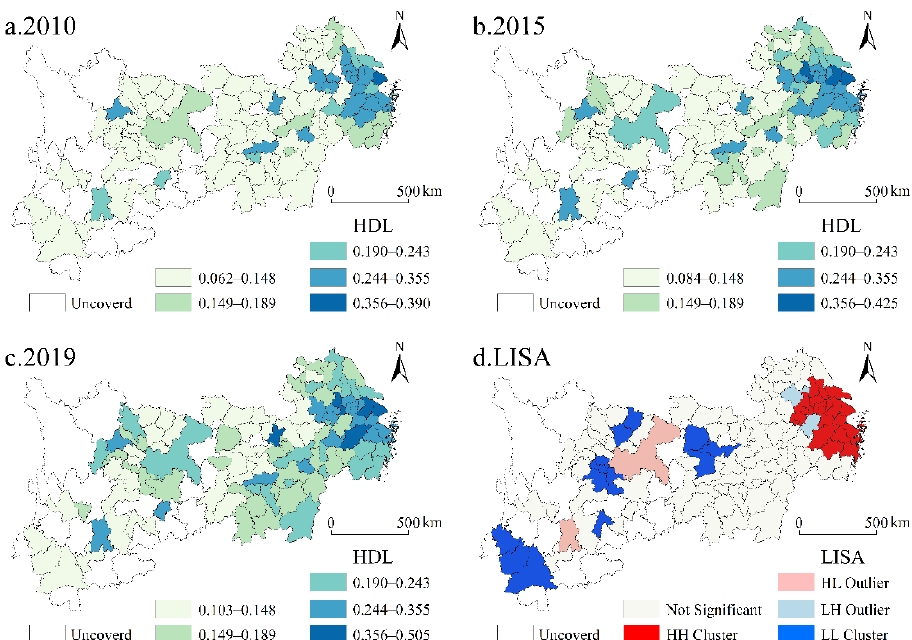
Figure 4. Spatiotemporal characteristics of HDL for the YREB. Note: ( a – c ) are the spatial patterns of HDL of 108 prefecture-level cities in the YREB in 2010, 2015 and 2019, respectively. ( d ) shows the cluster analysis using the average value of HDL of each city in the YREB from 2010 to 2019, with a global Moran’s I of 0.653 ( p < 0.01).